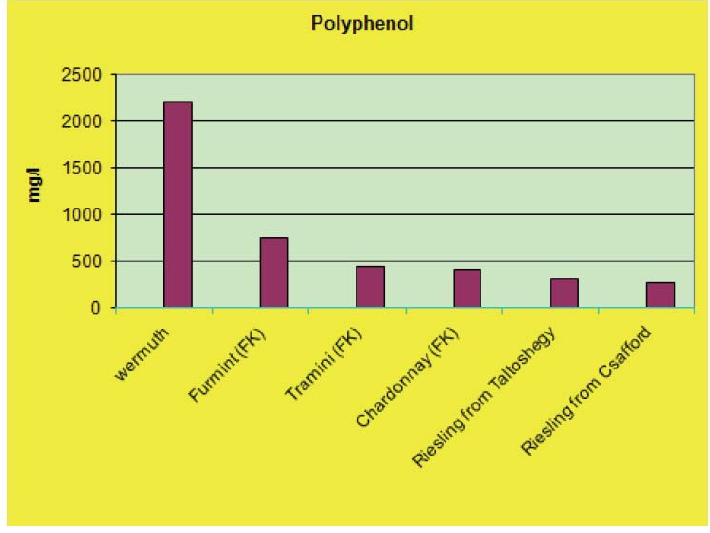
Fig. 2 Polyphenol content of some bottled wine varieties commercially available in Hun- gary (based on the data of J. Feher and A.